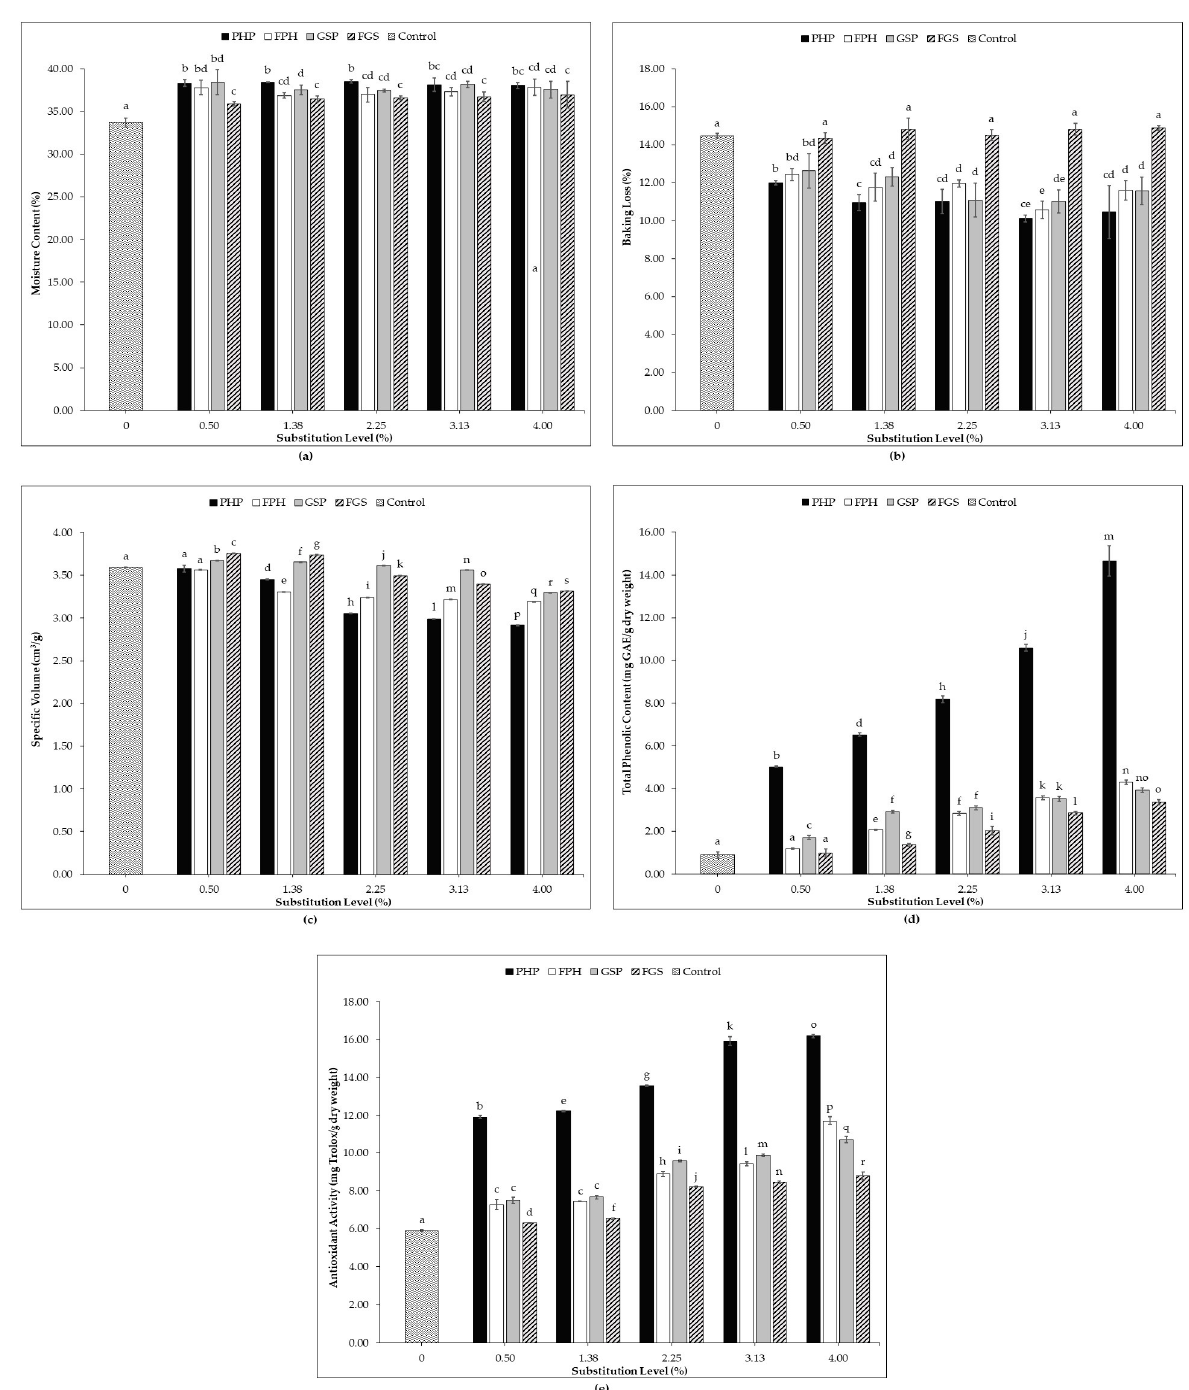
Figure 1. Moisture content ( a ), baking loss ( b ), specific volume ( c ), total phenolic content ( d ), and antioxidant activity ( e ) of control and enriched breads. Values of each parameter with the same letters were not significantly different ( p >